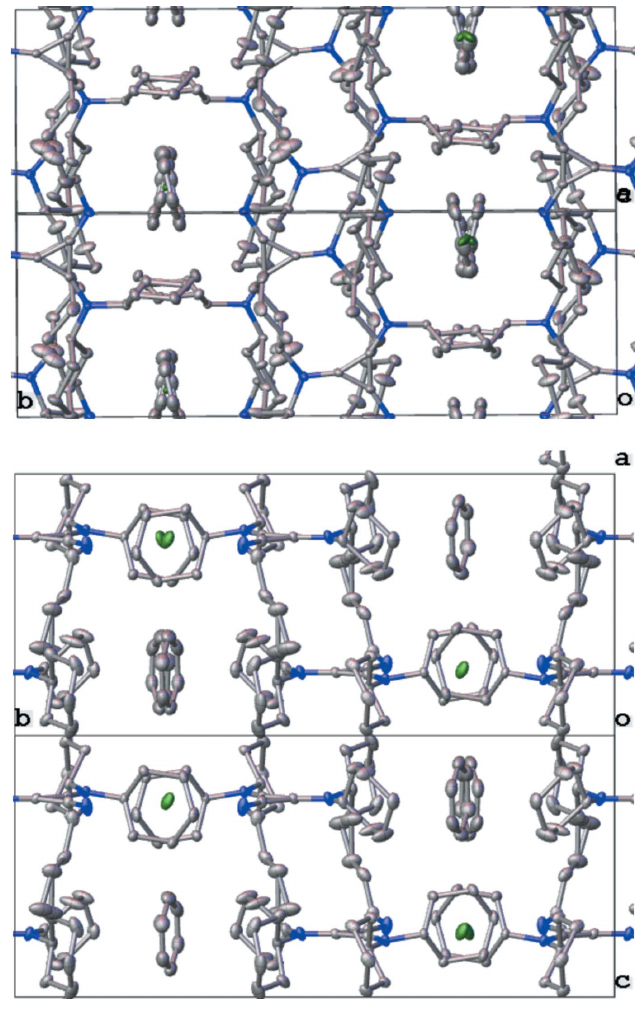
Figure 4 Top: Packed unit cell viewed along the 101 plane. Bottom: Packed unit cell viewed along the [101]